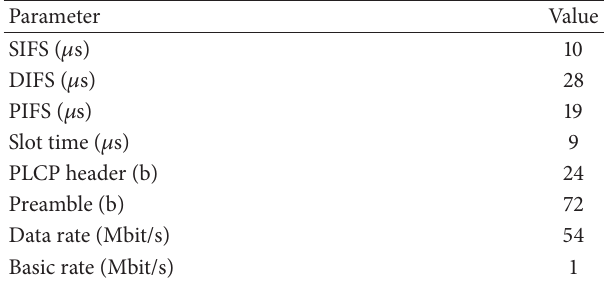
Table 1: MAC/PHY simulation